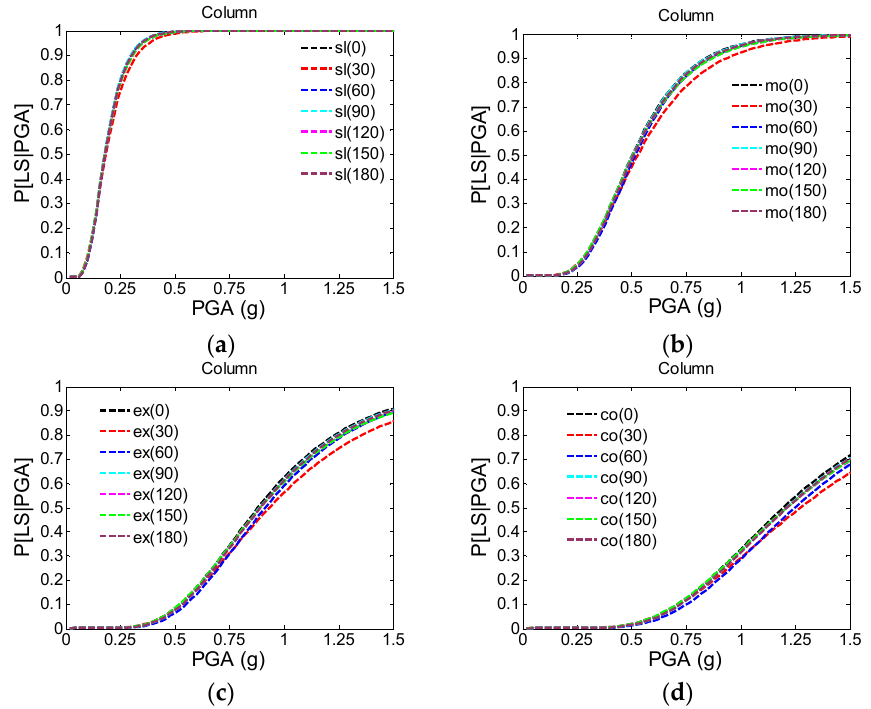
Figure 5. Seismic fragility curves of the column subjected to different excitation angles in the ( a ) slight; ( b ) moderate; ( c ) extensive; and ( d ) complete limit states.